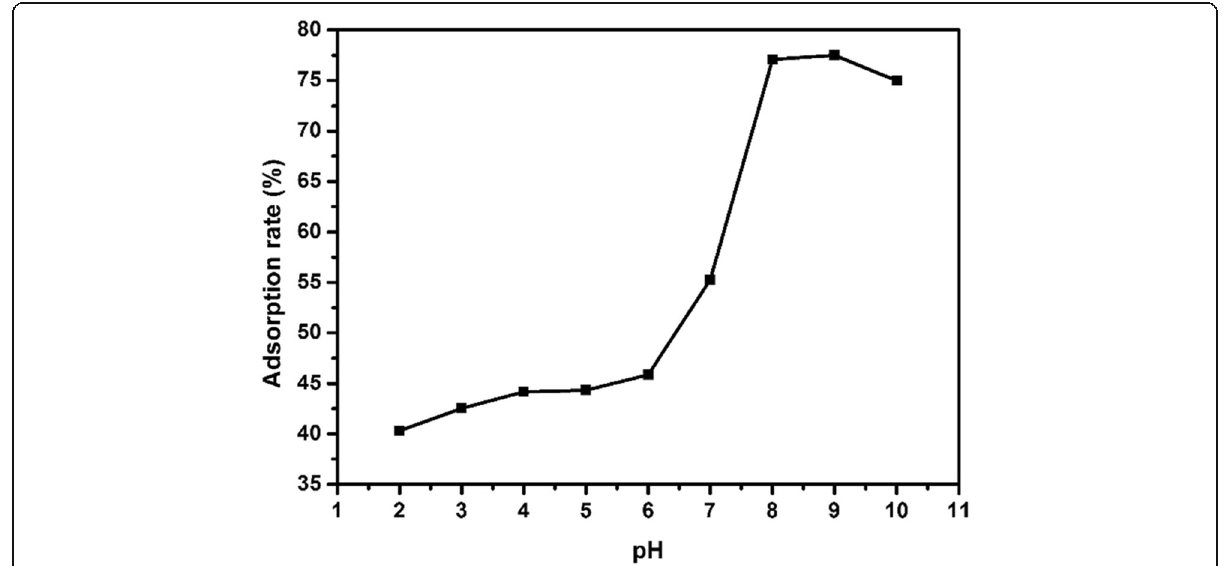
Fig. 6 Effect of different pH on adsorption of EE2 by nano-copper sulfide